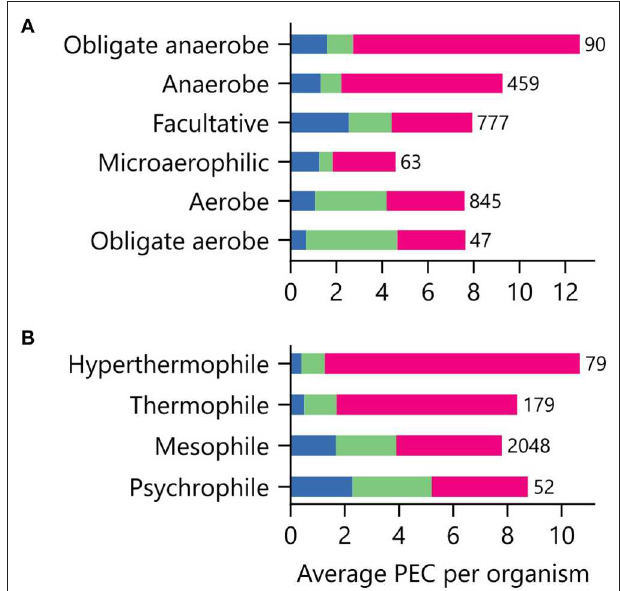
FIGURE 6 | Relationship between environmental niche and PEC use. The average PEC gene counts for organisms having different (A) O 2 requirements and (B) growth temperatures. Colors represent the counts of [4Fe-4S] Fd (red), [2Fe-2S] Fd (green), and Fld (blue) gene abundances. The number of genomes of each type is shown adjacent to the